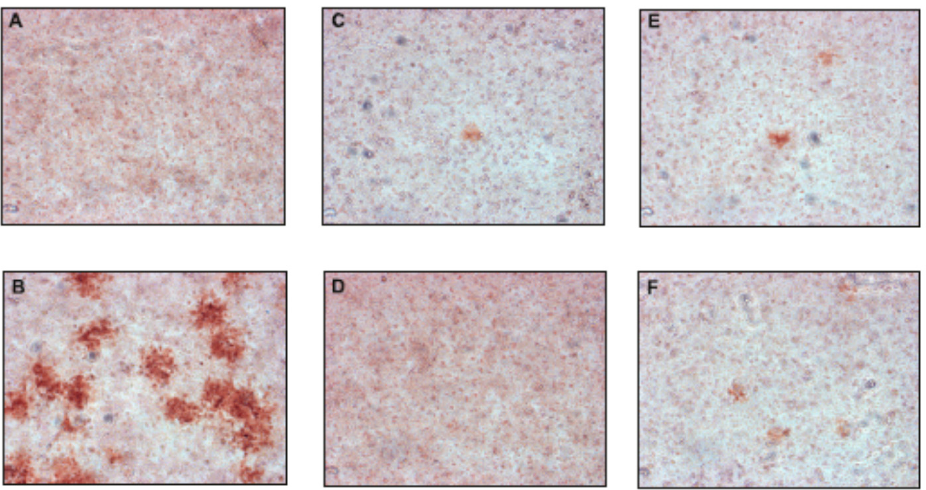
Figure 3. The effect of selected uridine derivatives of 2-deoxy sugars on TBEV propagation in A549 cells. A549 cells were infected with the TBEV Neudoerfl strain at an MOI of 0.001 ( B – F ) or mock infected ( A ). After virus removal at 2 h p.i., the cells were washed and overlaid with carboxymethylcellulose in Dulbecco’s Modified Eagle’s Medium with DMSO ( B ) or 50 µM of compounds 2 ( C ), 4 ( D ), 10 ( E ), and 11 ( F ). At 48 h p.i., cells were fixed and infected foci were visualized by immunostaining with the monoclonal anti-Flavivirus group antigen antibody (4G2).